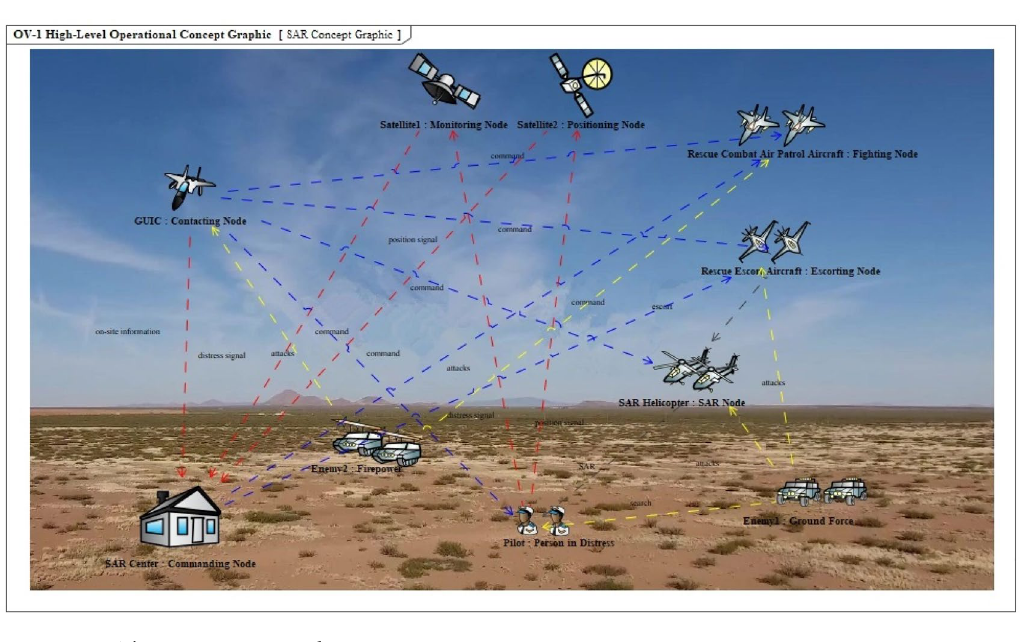
Figure 7. The SAR concept graphic.